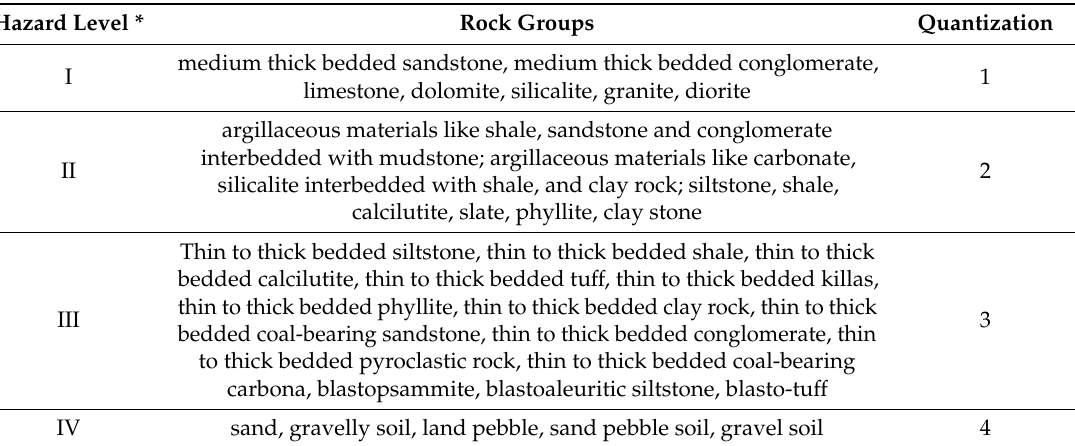
Table 1. Classification of rock